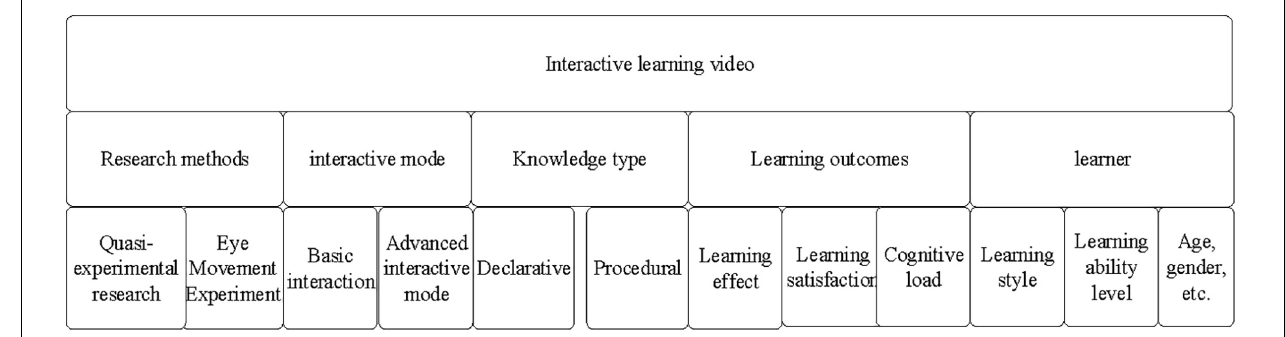
FIGURE 1 | Framework of interactive learning